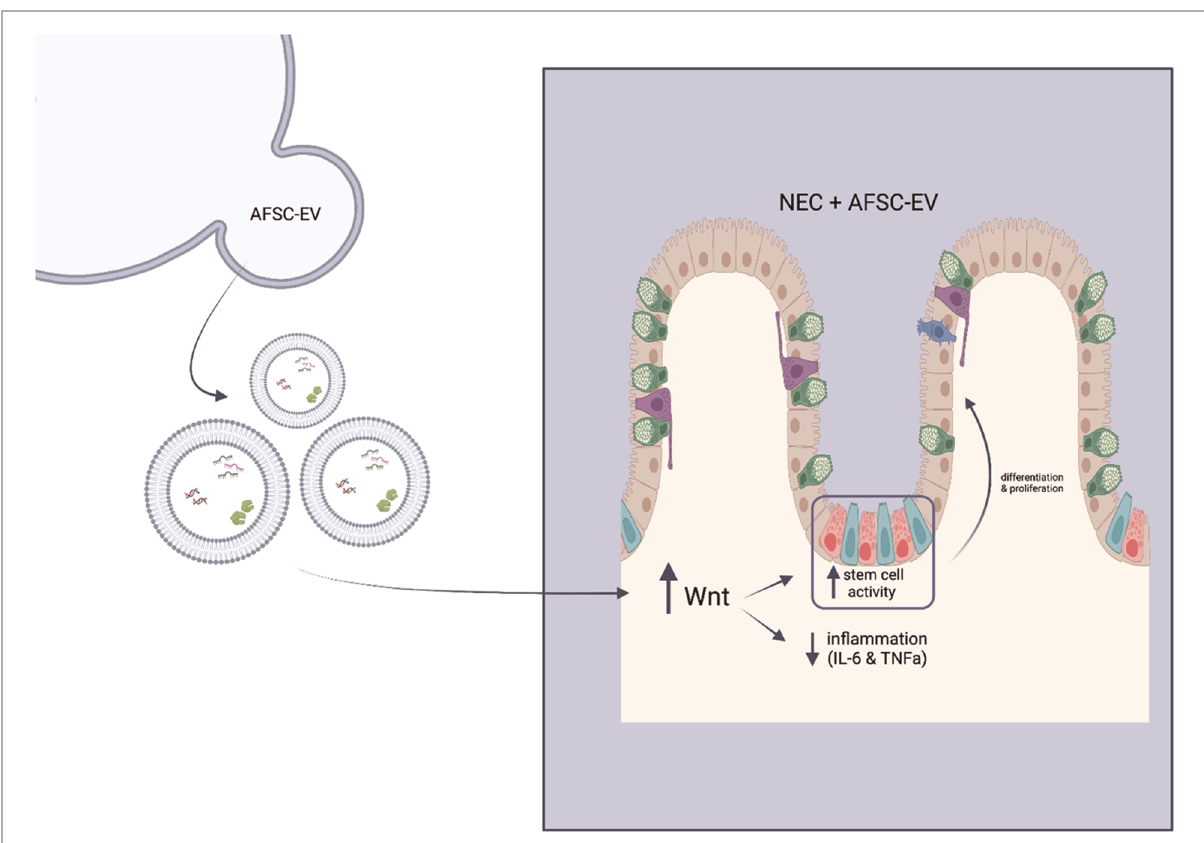
FIGURE 3 Schematic of mechanism of action of hAFSC-EVs. Wnt signalling becomes enhanced upon administration of hAFSC-EVs, which in turn increases stem cell activity and decreases in fl ammatory